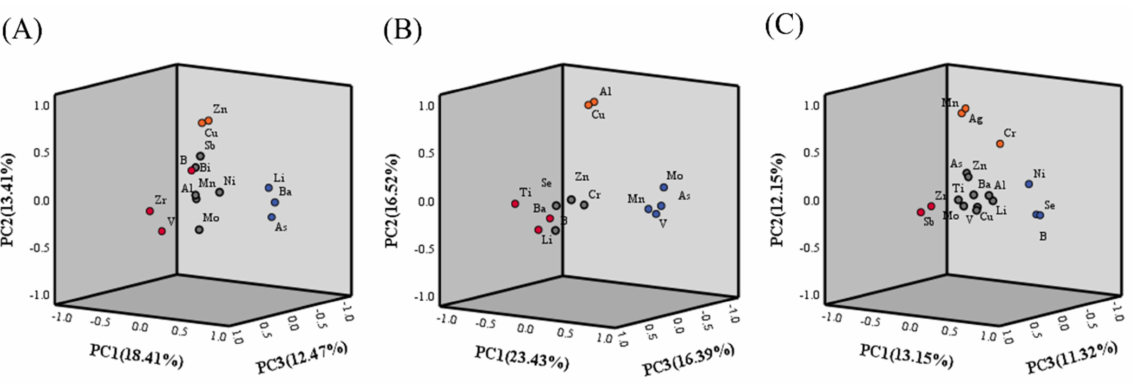
Figure 7. Principal component analysis (PCA) for heavy metals in HLJ ( A ), BJ ( B ), and NMG ( C ). For heavy metals in well water from BJ, five PCs with eigenvalues greater than 1.0 were extracted, with three key PCs (PC1–PC3) cumulatively explaining 76.24% of the total variance (Figure 7B). PC1 accounted for 23.43% of the total variance, with strong positive loadings of Mo, As, V, and Mn and factor loading values greater than 0.7. These elements may be derived mainly from parent material weathering and pedogenic processes [21,37]. PC2 accounted for 16.52% of the total variance and had strong positive loadings for Al and Cu, both of which may have a lithogenic origin. They may originate from the crust or be formed from carbonate mineral weathering and leaching of the host rock of aquifers [14,21]. PC3 accounted for 16.39% of the total variance and had strong positive loadings for Ti, Ba, and Li. These elements may be predominantly of geogenic origin, derived from multiple primary mineral sources